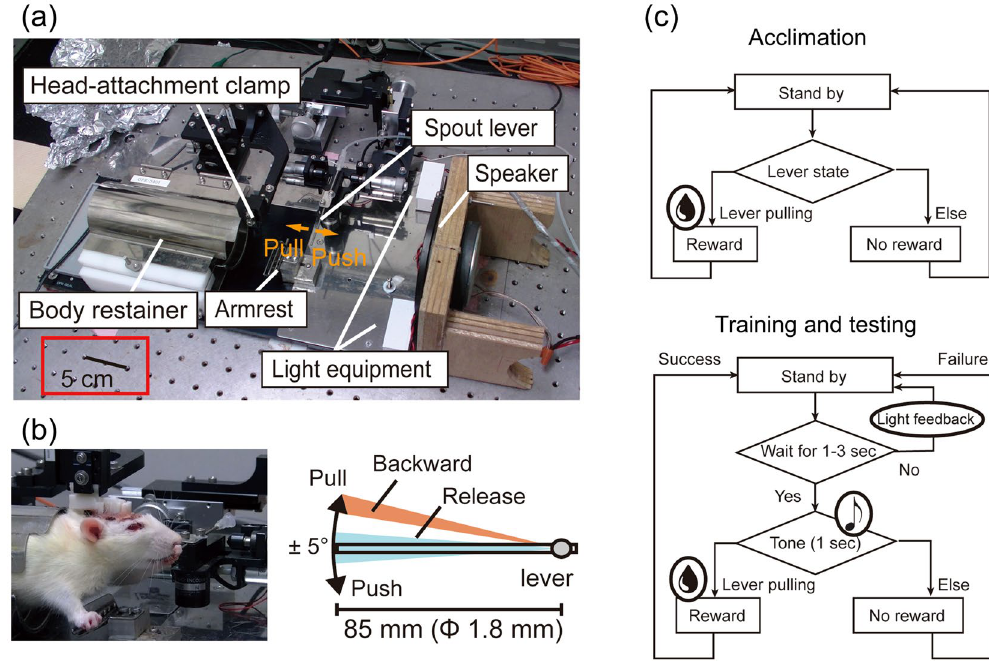
Figure 1. An overview of the experimental system. ( a ) The parts comprising the system. ( b ) A head-restrained animal being trained to pull a spout lever in response to auditory stimuli (see Supplementary Video S1). ( c ) Diagrams of acclimation, training, and testing